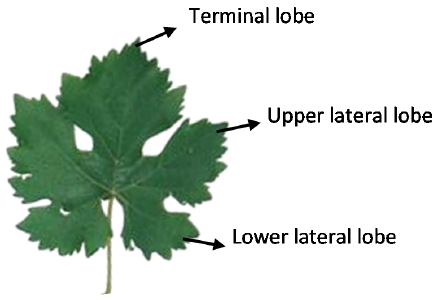
Figure 3. Vine grape leaf type structure.